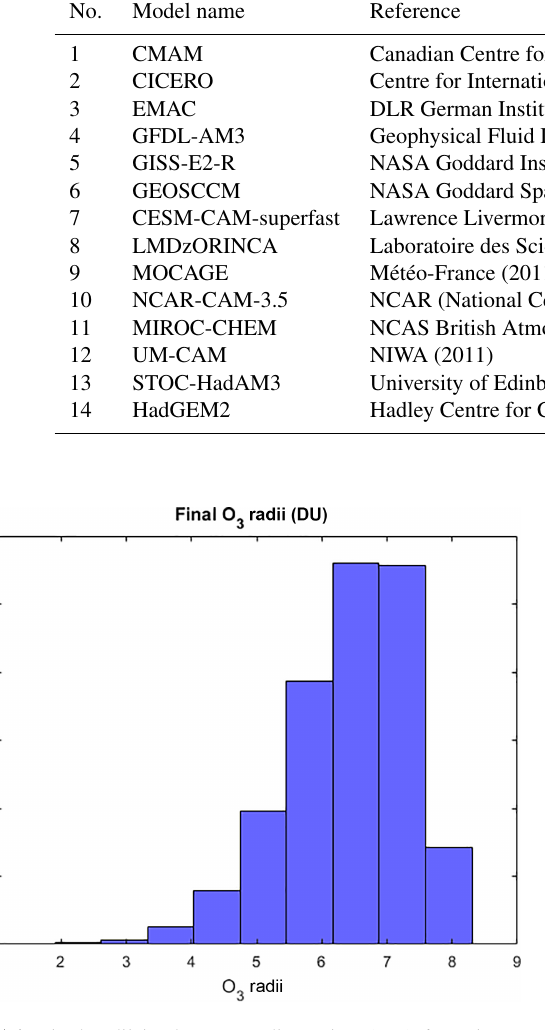
Figure A1. Final radii in the ozone dimension (DU) for primary clusters.